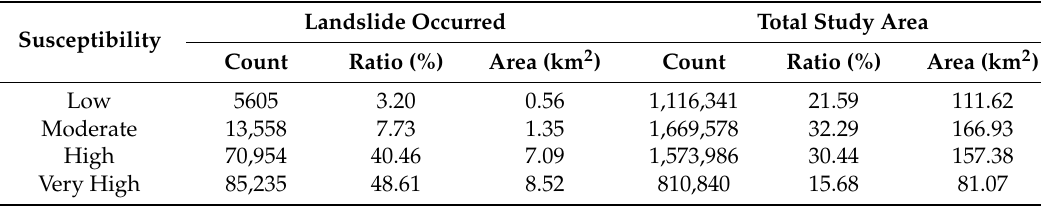
Table 6. Statistical results of landslide susceptibility mapping using grid